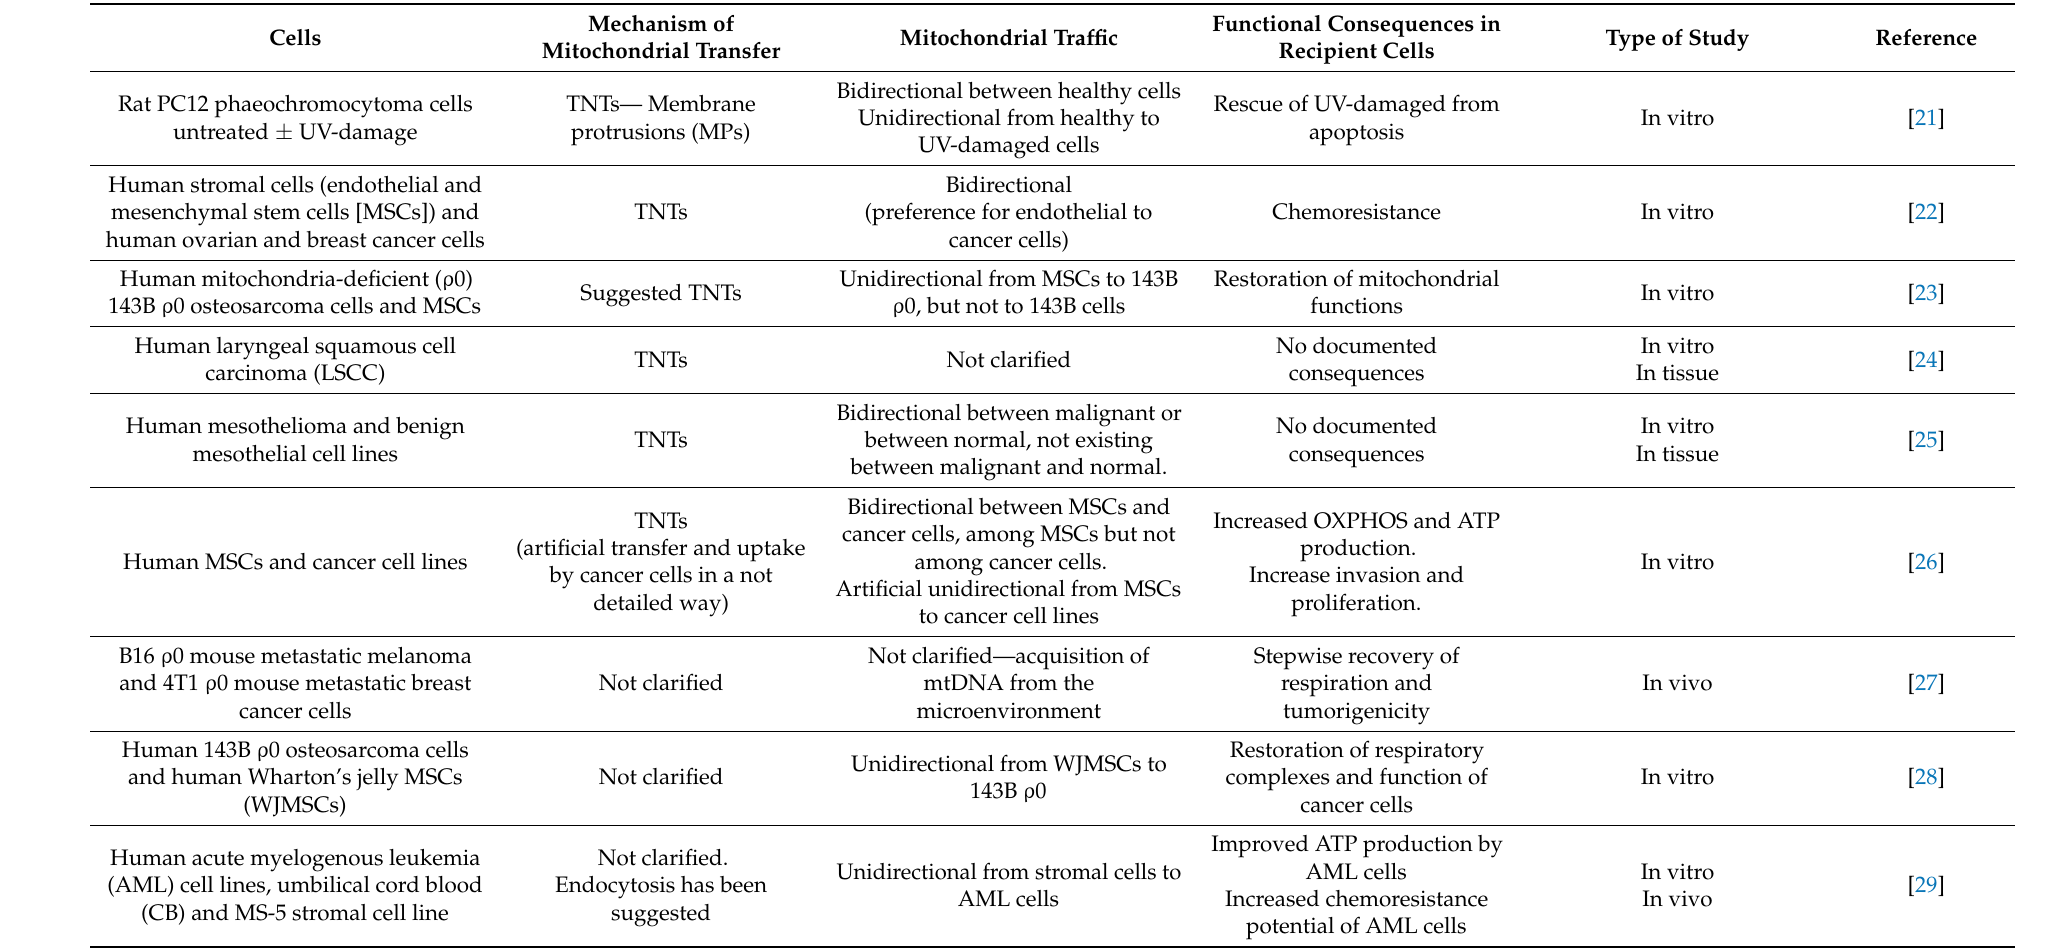
Table 1. Mitochondrial transfer involving cancer cells